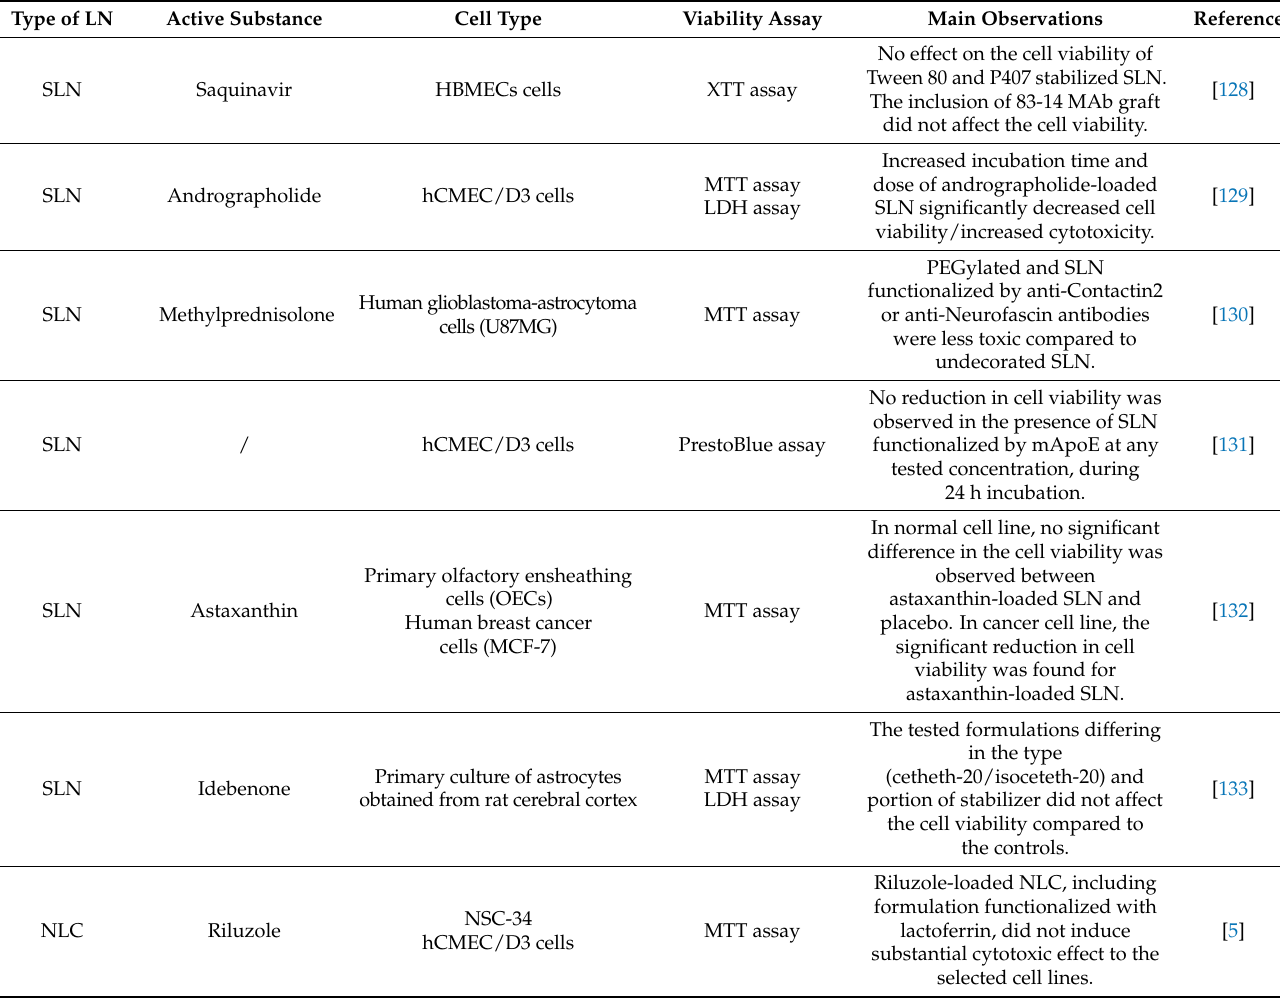
Table 4. Examples of the studies investigating the in vitro cytotoxicity of lipid-based nanoparticles intended for the treatment of CNS